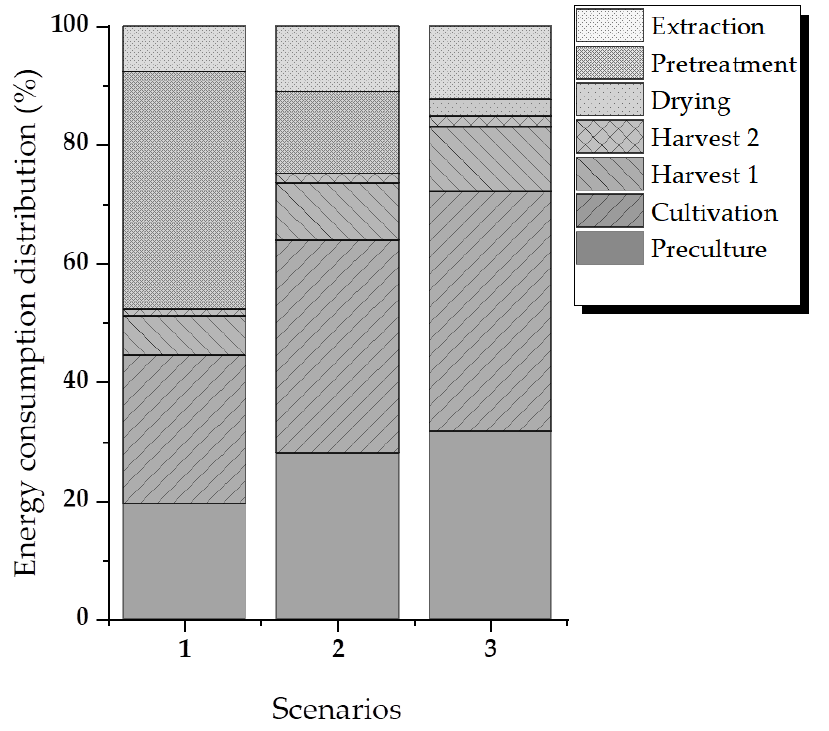
Figure 6. Distribution of energy consumption for scenarios 1, 2, and 3.